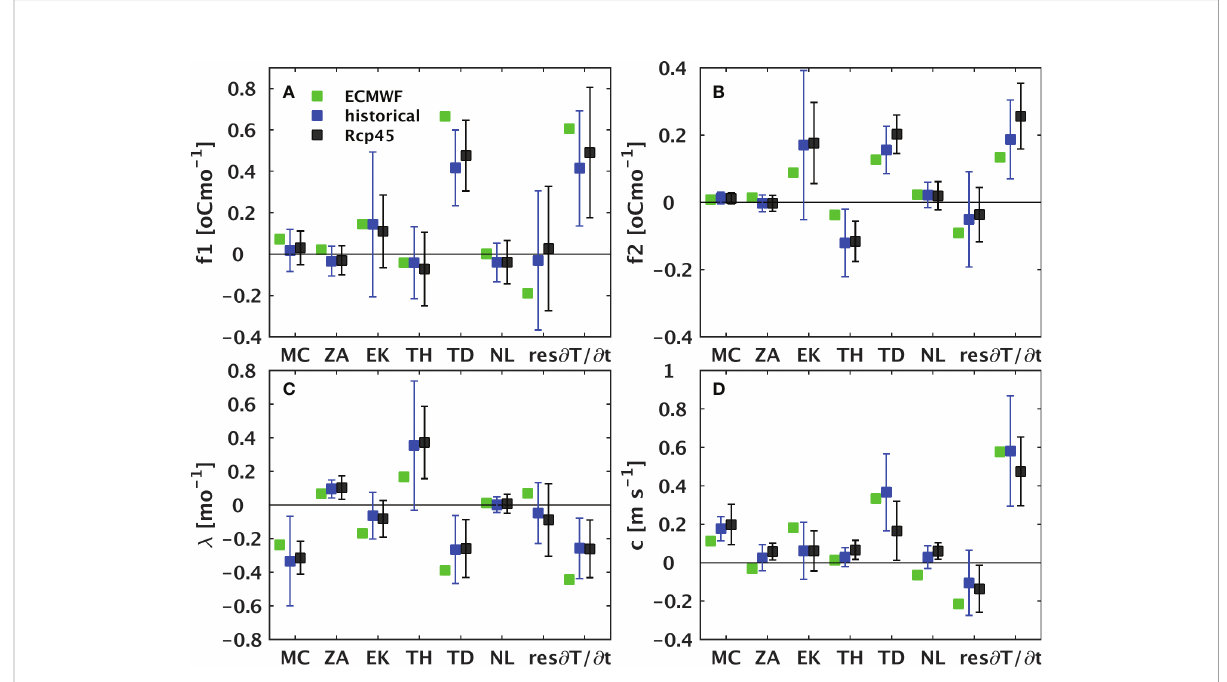
FIGURE 6 Diagrams for total and individual contribution from the different feedback terms (MC, ZA, EK, TH, TD, NL and Res) of the SST tendency (Tt) to (A) the annual and (B) semi-annual harmonic external forcing (ºC month -1 ), (C) the damping rate (month -1 ) and (D) the westward propagation speed (m s -1 ) based on the ECMWF reanalysis dataset (green squares), MME in the historical period (blue squares) and RCP4.5 scenario (black squares). Whiskers represent the inter-model standard deviation.